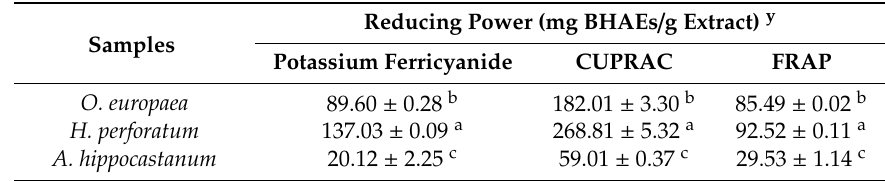
Table 5. Reducing power action of the water extracts from plants x